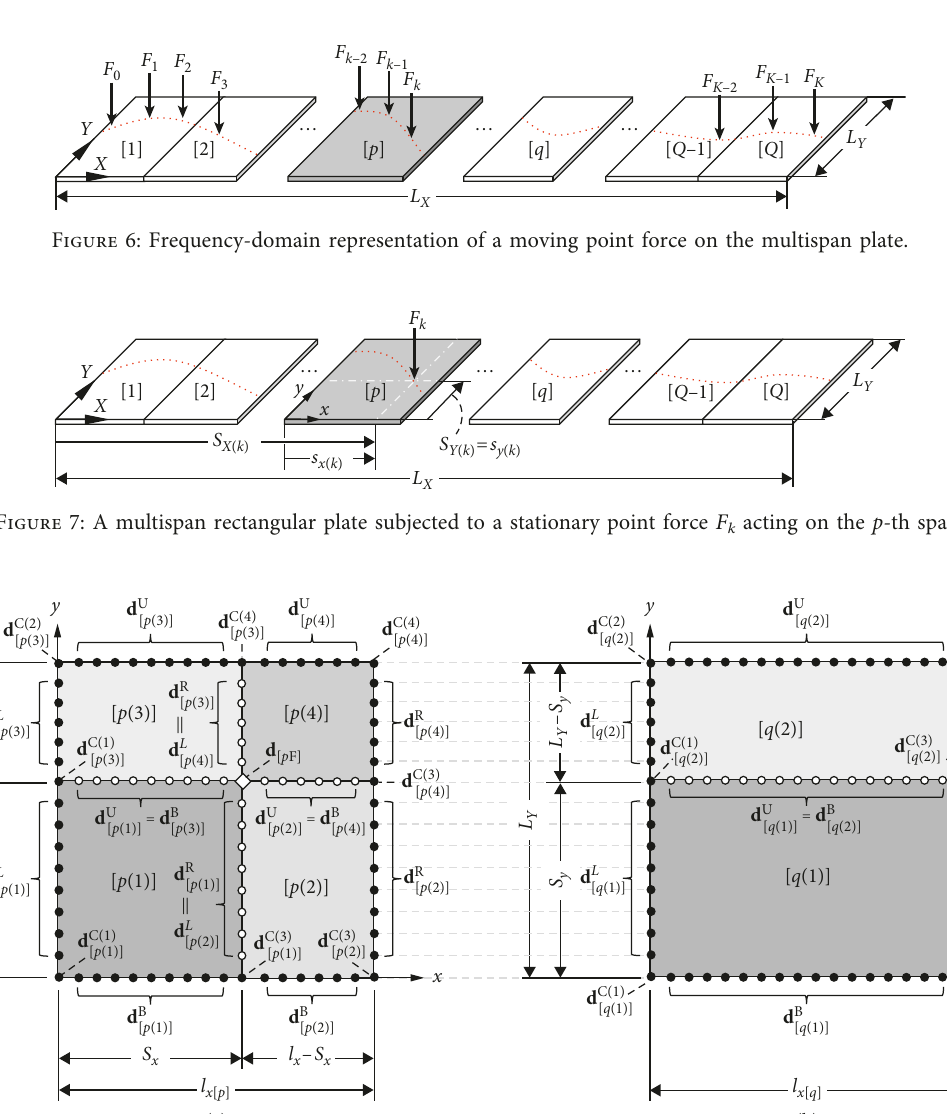
k and (b) two-element model for the spans that are free the nodes on the boundary edges, and the node at which the stationary point force F k is located, • (cid:31) (cid:31) p , (b) when q p (cid:31) ◇